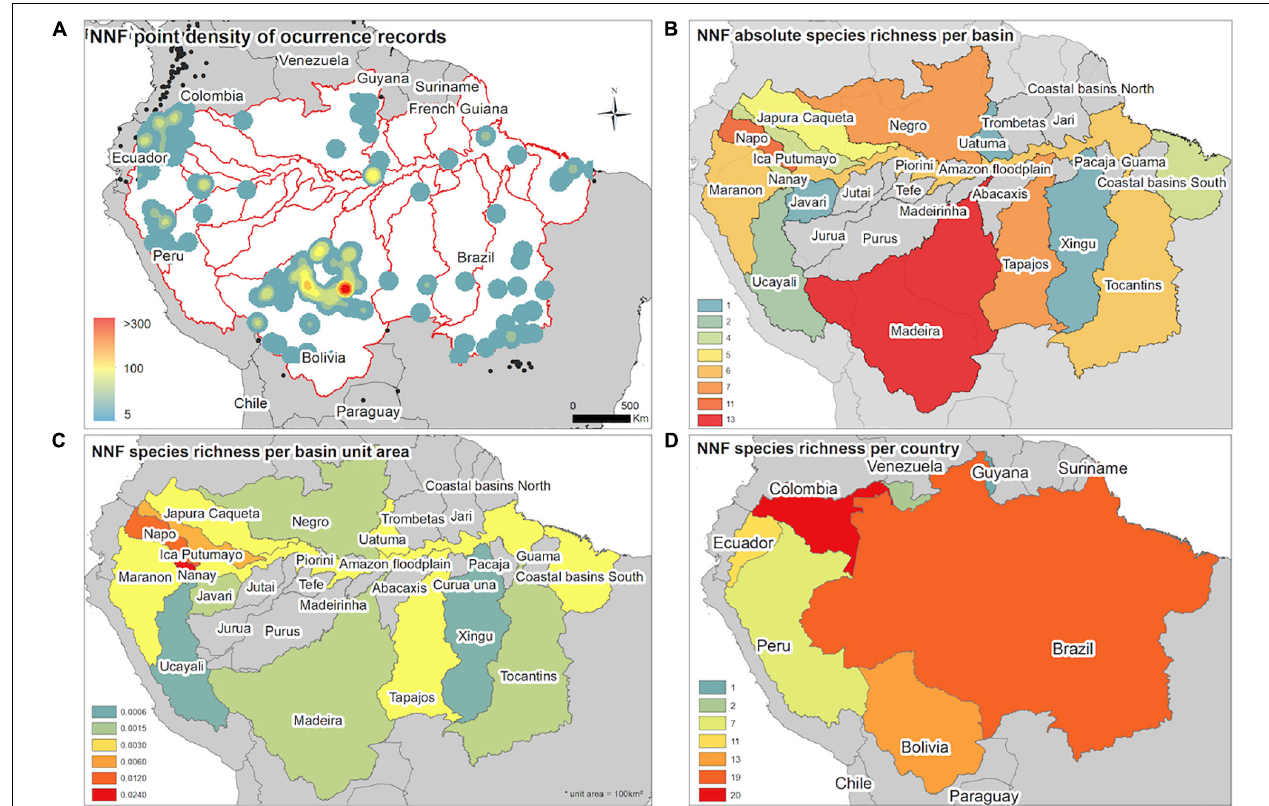
FIGURE 1 | Geographical distribution of occurrence records of NNF in the Amazon (A) and richness per basin (B) , richness per basin unit area (C) , and per country (D) , until 2020. The choropleth scale shows an increasing NNF richness, ranging from lower values indicated in blue to highest values indicated in